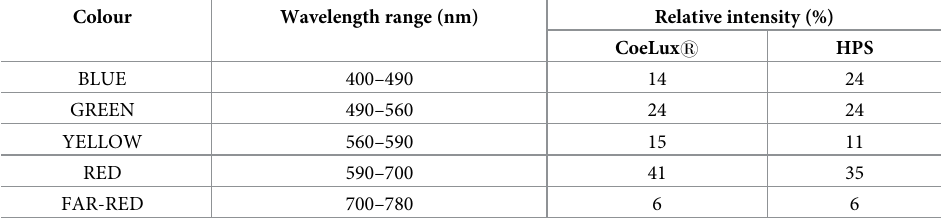
Table 1. Spectra colour composition of the two light types used in this study. Colour Wavelength range (nm) BLUE YELLOW RED